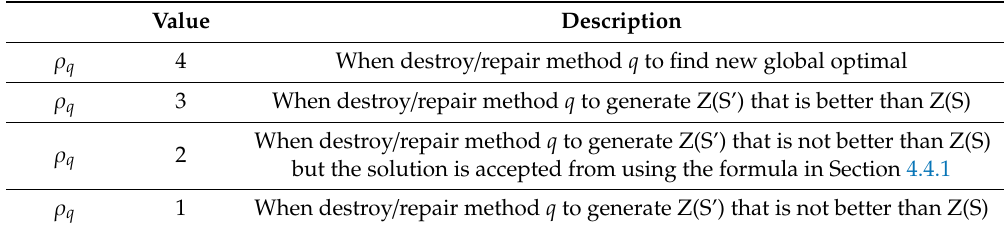
Table 6. Value of ρ q to be used to update the information.